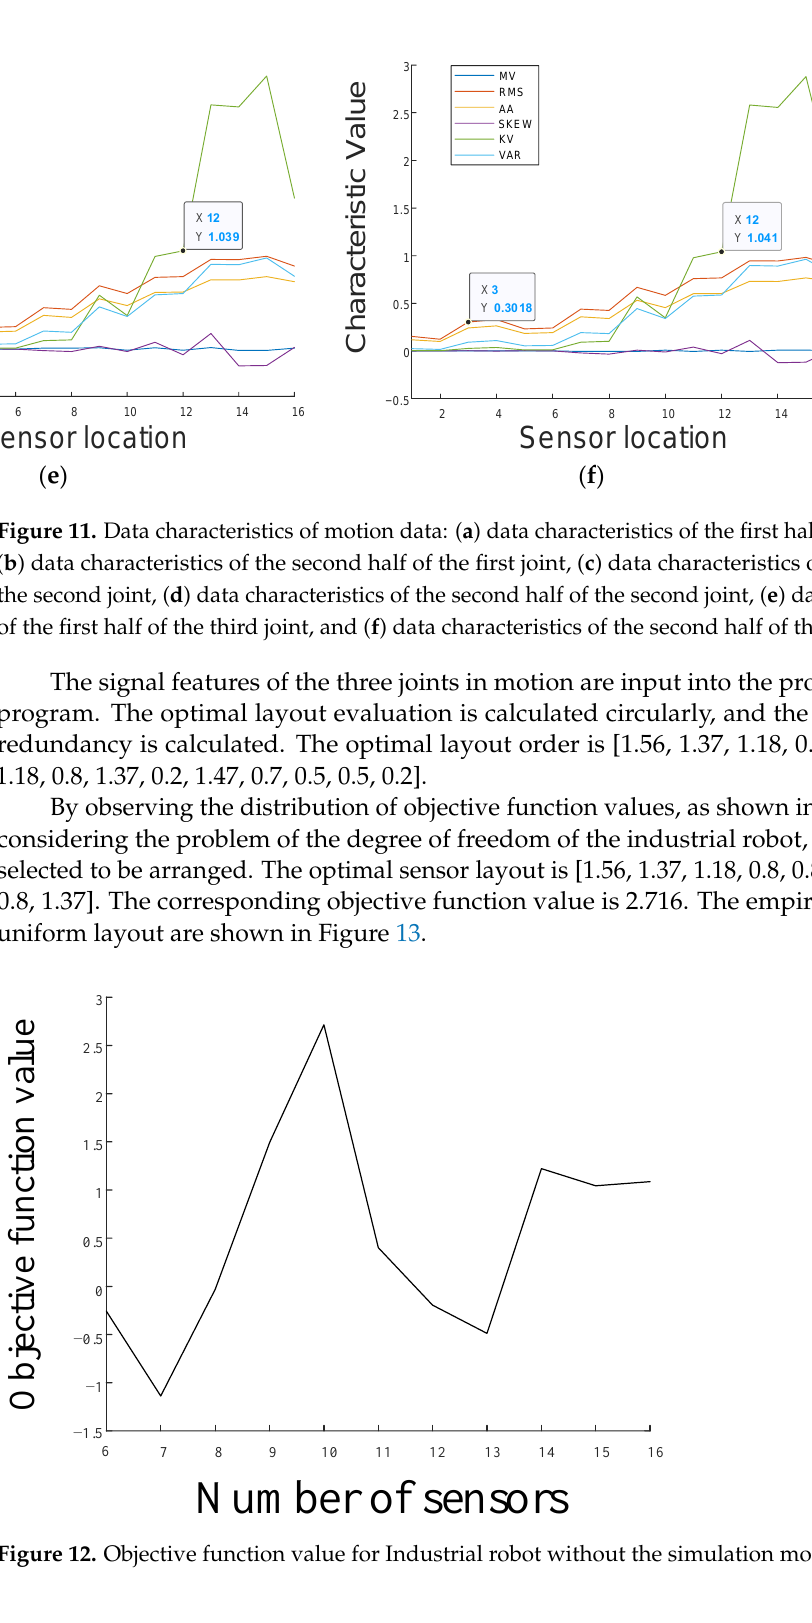
Figure 12. Objective function value for Industrial robot without the simulation model.